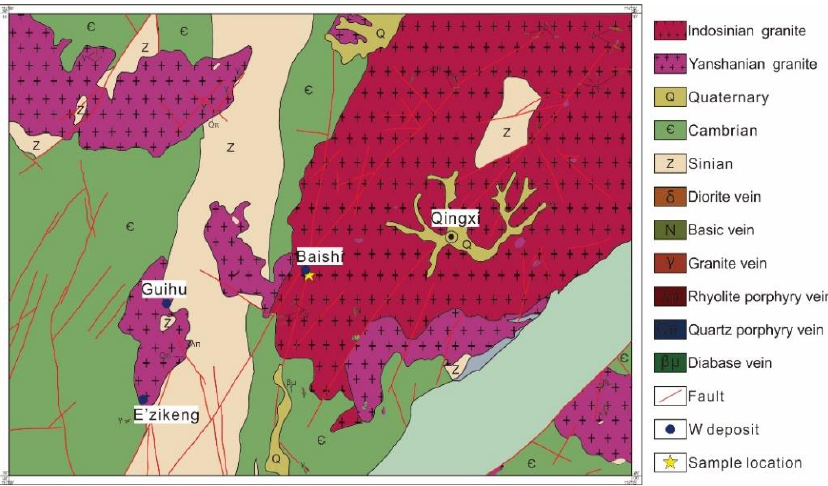
Figure 3. Geological deposit map of Baishi W-Cu deposit region (modified from [33]).